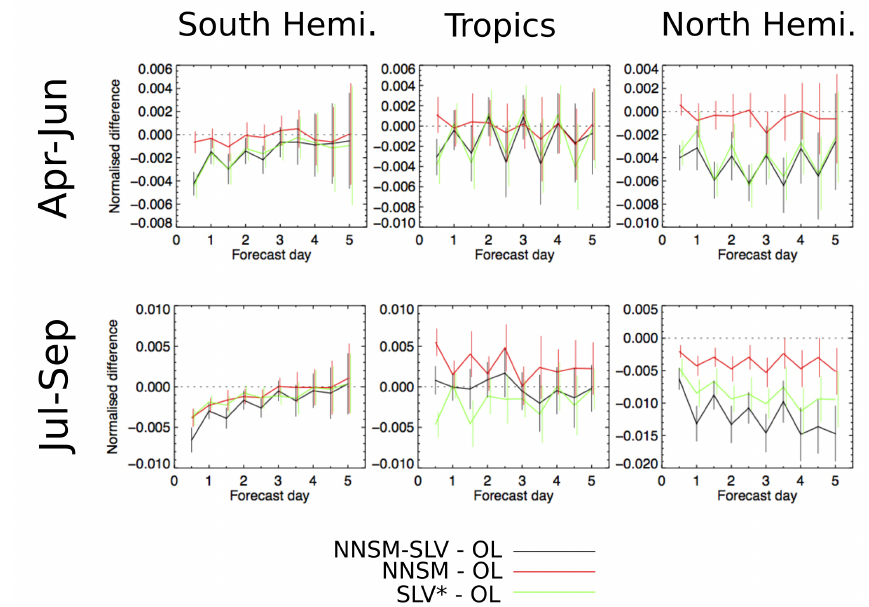
Figure 10. Evaluation of the atmospheric forecast skill. The plots show the RMSE of the T 2m forecast for the assimilation experiments minus the RMSE for the OL experiment as a function of the forecast day in two periods: April–June ( upper panels ) and July–September ( lower panels ). The results are shown for three latitude ranges: [ − 90 ◦ , − 20 ◦ ] ( left panels ), [ − 20 ◦ , 20 ◦ ] ( middle panels ), [20 ◦ , 90 ◦ ] ( right panels